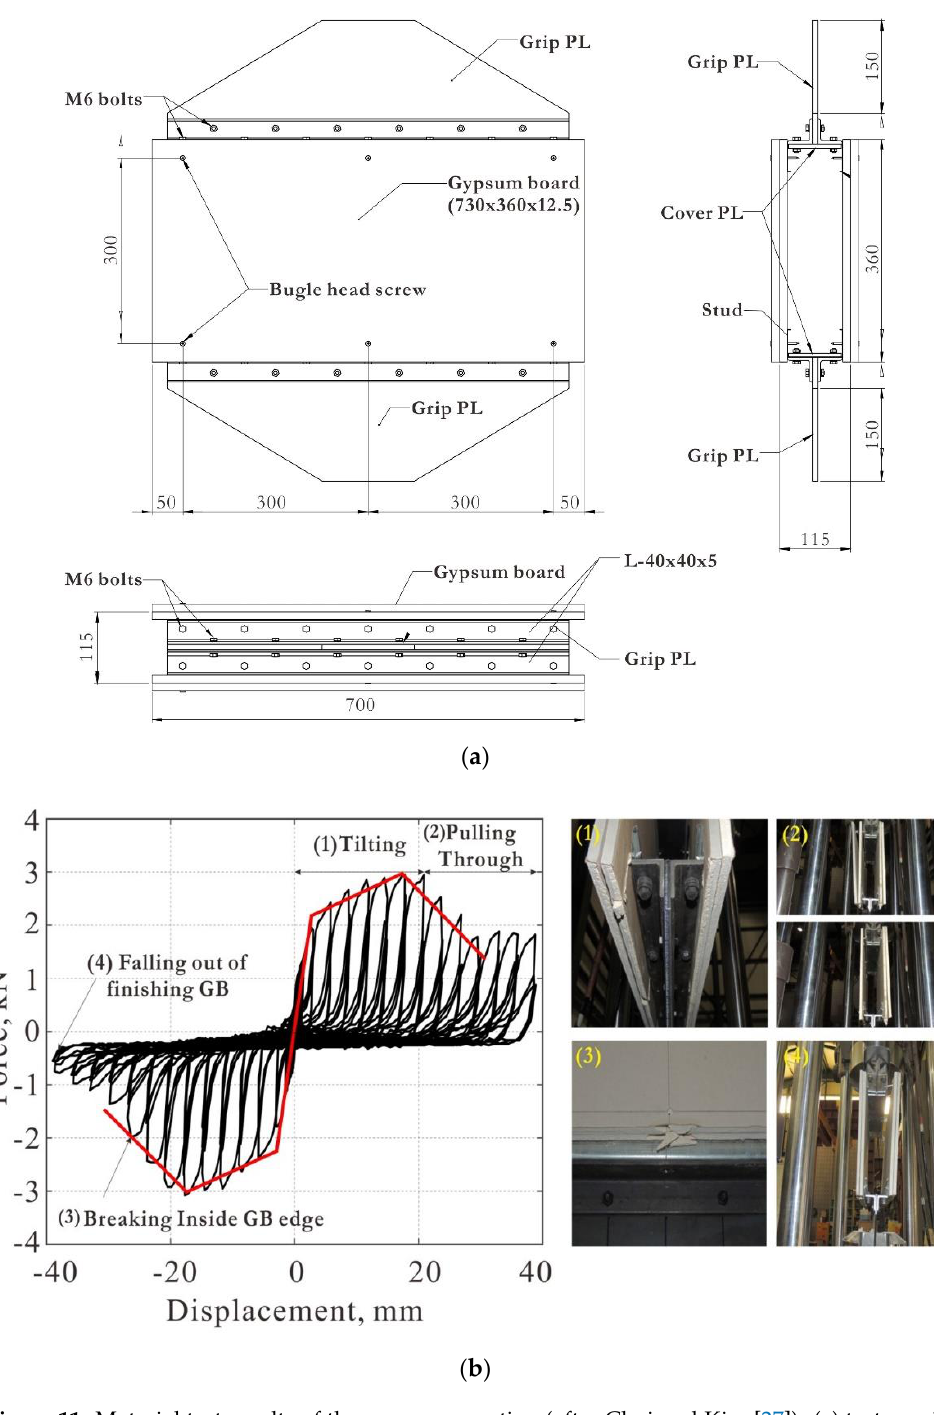
Figure 11. Material test results of the screw connection (after Choi and Kim [27]): ( a ) test specimen; ( b ) test result.